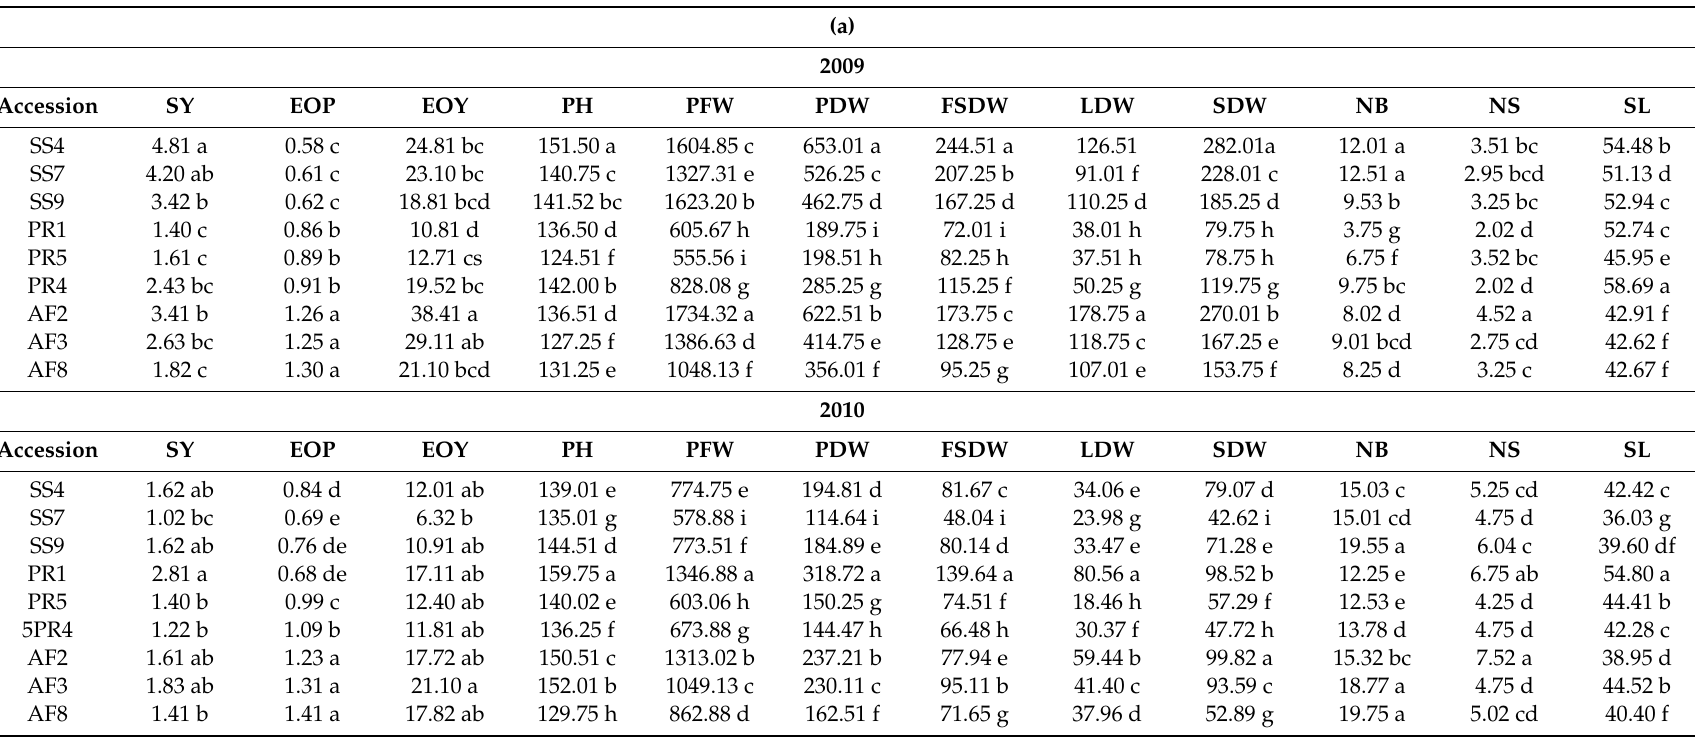
Table 7. (a) Mean values of biometric and productive parameters of clary sage accessions during 2009 and 2010. ( b ) Mean values of biometric and productive parameters of clary sage accessions during 2009 and